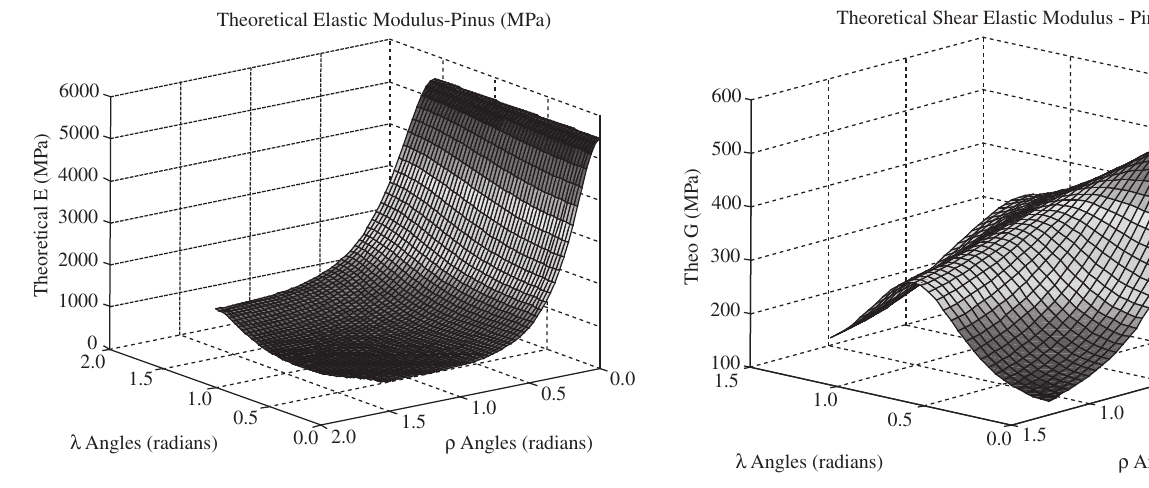
Figure 8. Three -Dimension diagram of Young´s Elastic Modulus and Euler’s angles for Pinus.